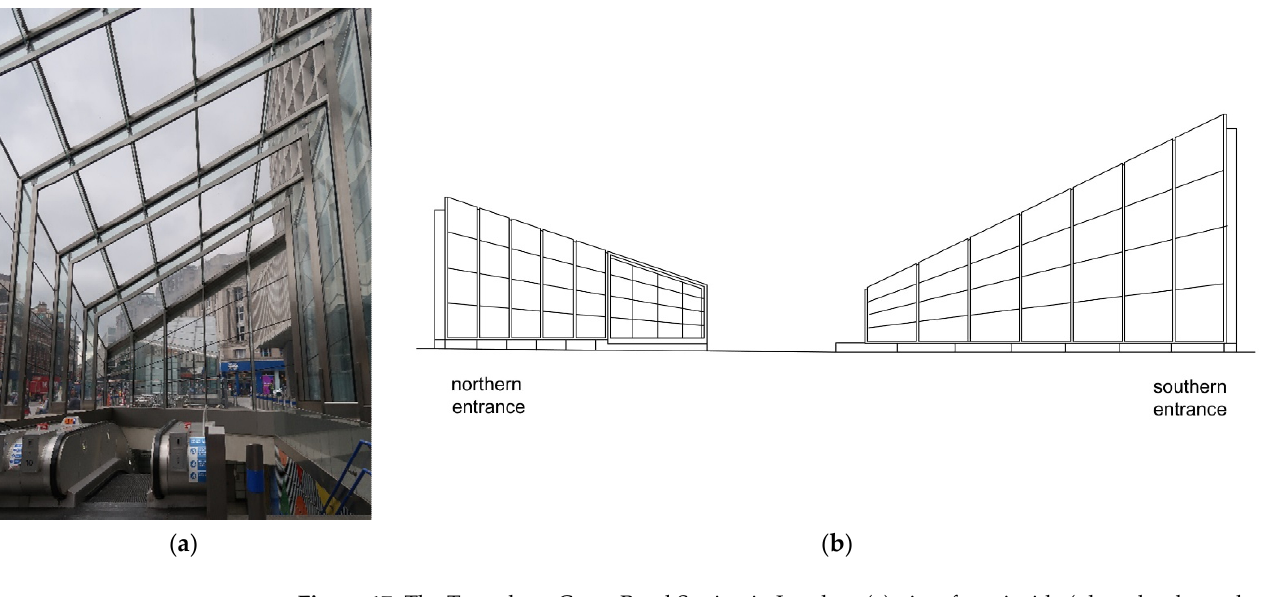
Figure 17. The Tottenham Court Road Station in London: ( a ) view from inside (photo by the author); ( b ) western facades of pavilions from Charing Cross Road (figure by the author).